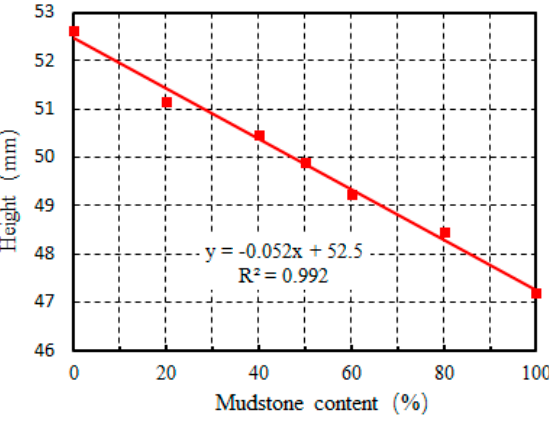
Figure 5. The relationship between the height and the mudstone content of b1~h1.